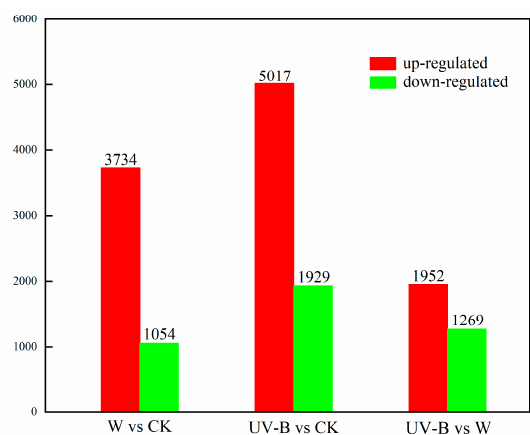
Figure 3. Number of DEGs identified from carrots under different